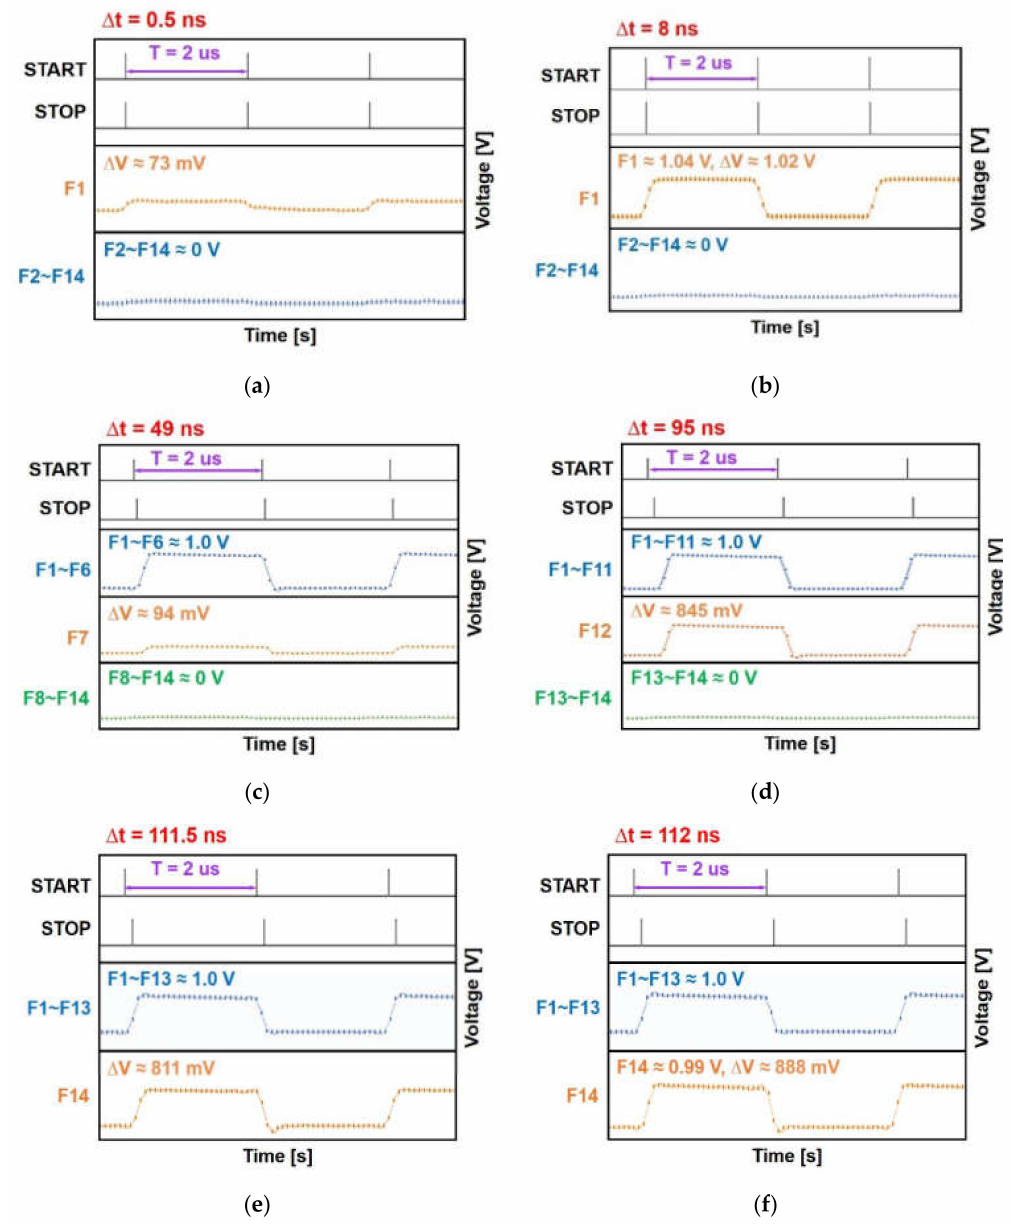
Figure 7. Measured results of the proposed I-TDC for ( a ) 0.5 ns, ( b ) 8 ns, ( c ) 49 ns, ( d ) 95 ns, ( e ) 111.5 ns, and ( f ) 112 ns time interval,